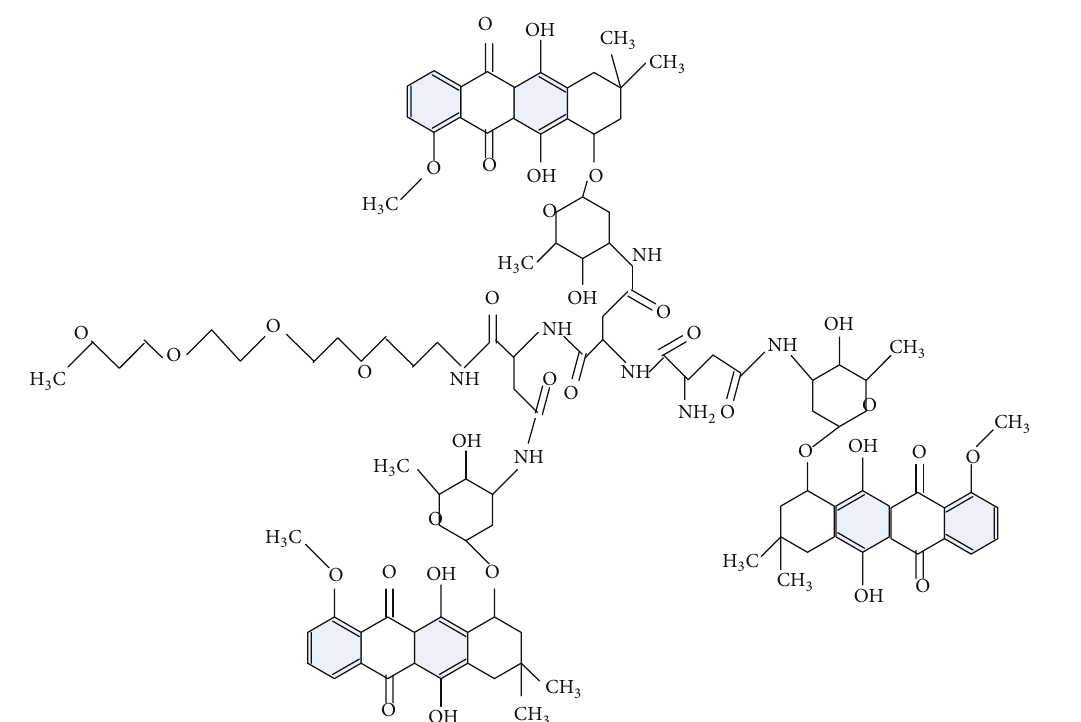
Figure 4: The molecular structure of 𝑆𝑃[3]